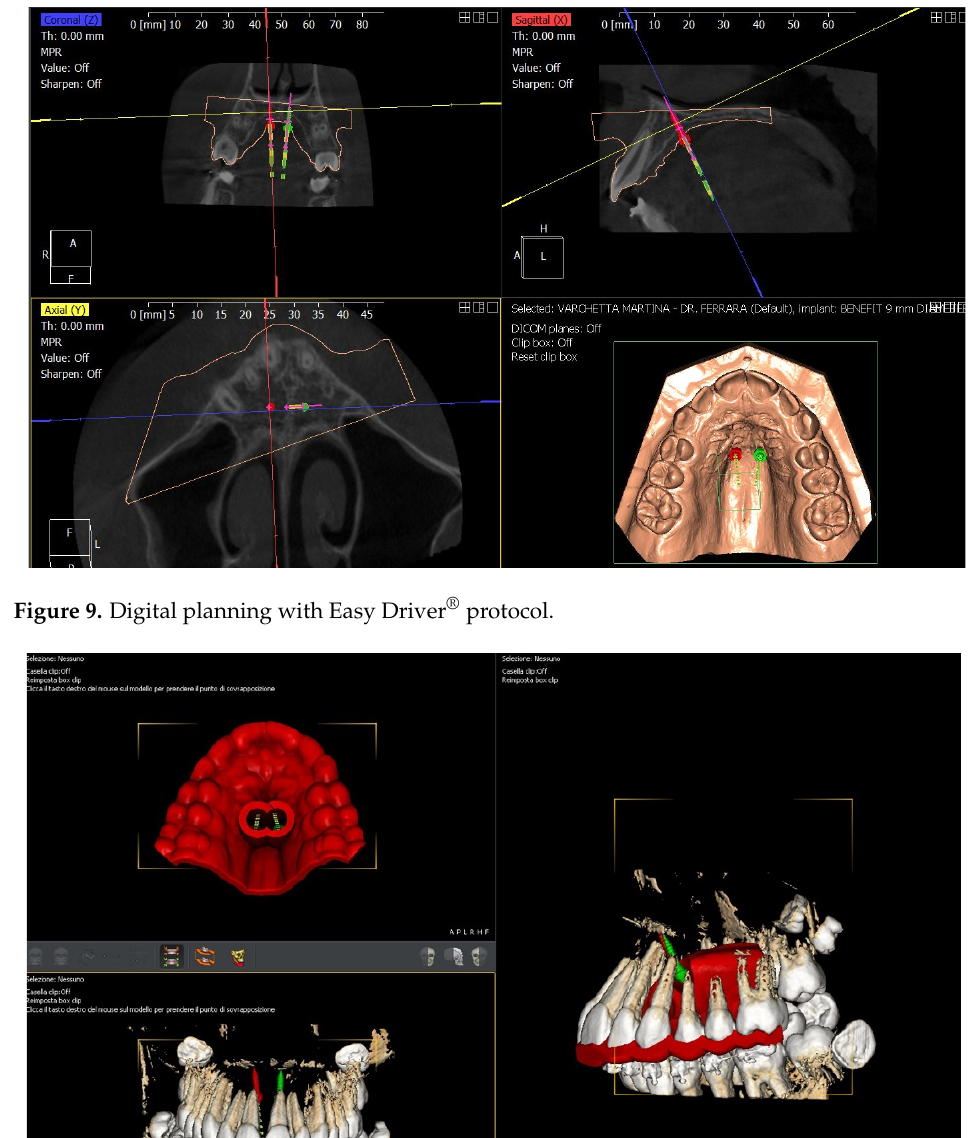
Figure 10. Digital plan of the TADs insertion guide.